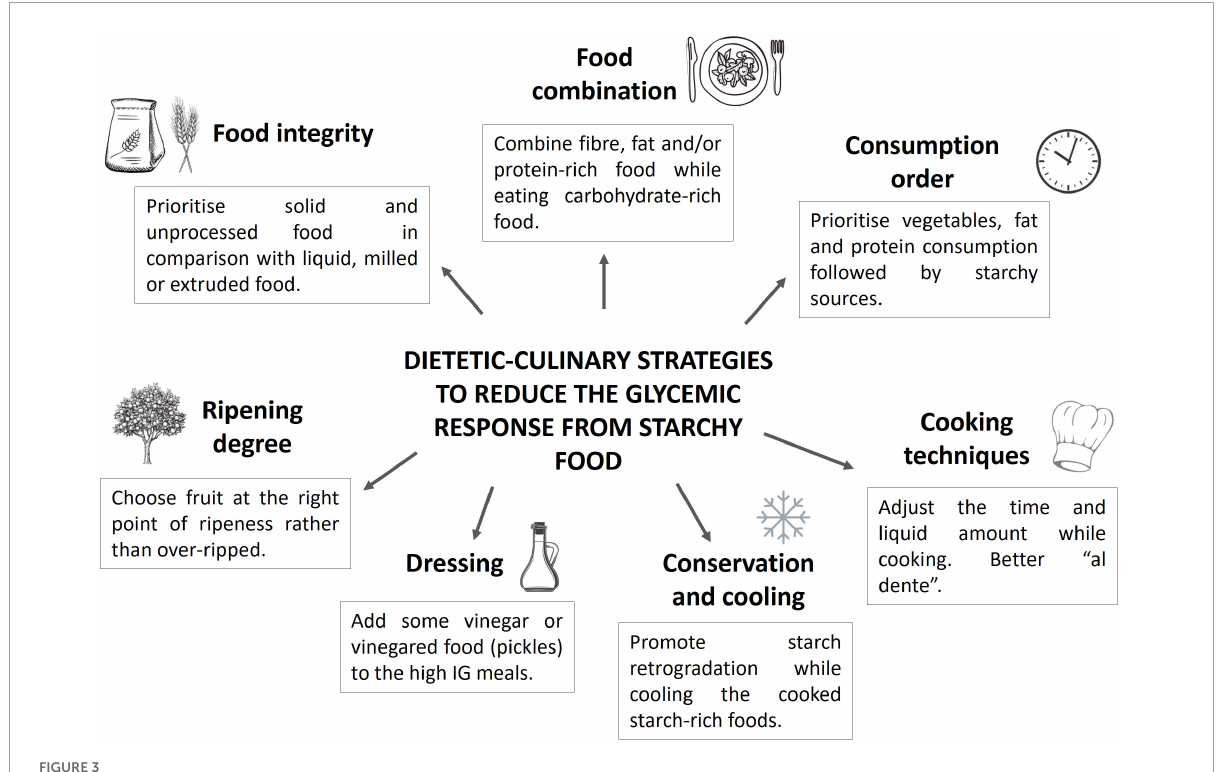
FIGURE3 Overview of dietary strategies to reduce glycemic response from starchy foods.